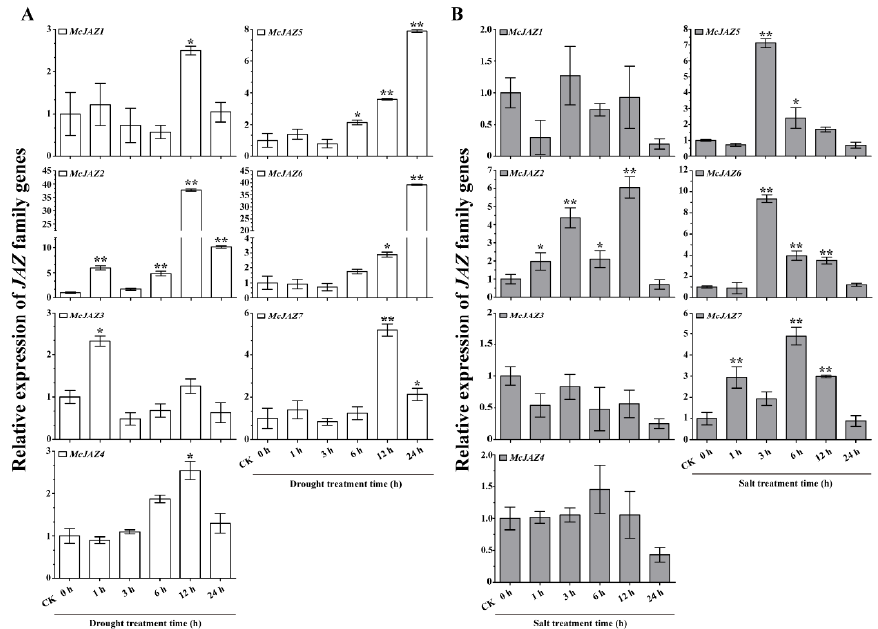
Figure 6. Expression profiles of McJAZ genes under drought and salt stress treatments. Quantitative real-time (qRT)-PCR analysis of the expression levels of McJAZ1 , McJAZ2 , McJAZ3 , McJAZ4 , McJAZ5 , McJAZ6 , and McJAZ7 in the two-week-old M. canadensis seedlings under drought ( A ) or 150 mM NaCl ( B ) treatments for 0, 1, 3, 6, 12, and 24 h. The relative expression level of each McJAZ gene was normalized to β -actin gene and compared with CK (0 h) as reference using the 2 − ∆∆ CT method. Data are presented as means ± SE of three independent replicates from three propagated cuttings. Asterisks indicate significant differences between the expression level of each McJAZ gene in CK (0 h) versus other time points were analyzed by Student’s t -test (* p < 0.05 or ** p < 0.01). CK (0 h) represents an independent control under identical